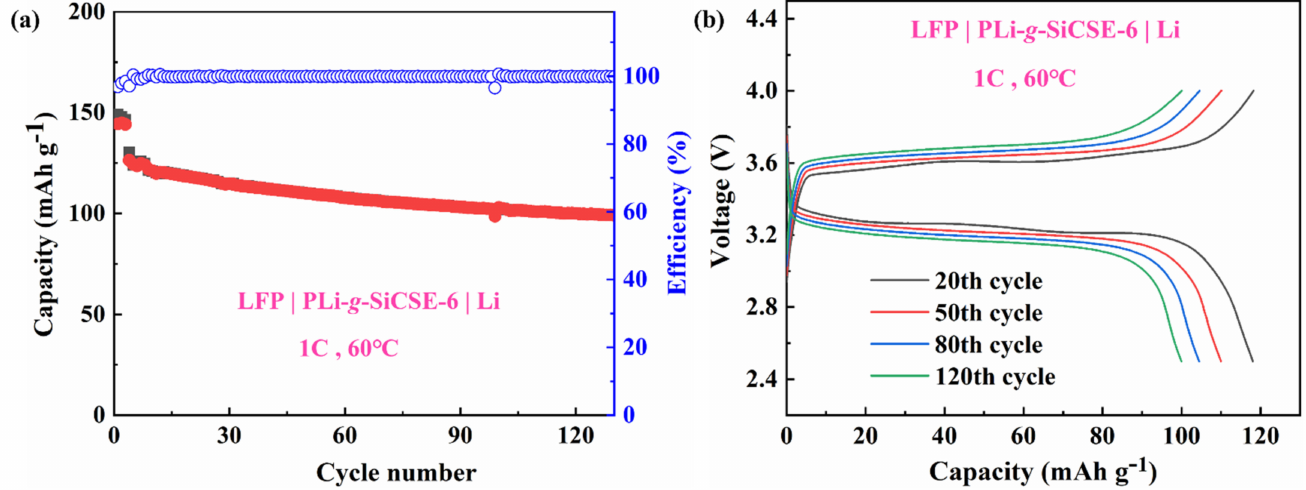
Figure 13. ( a ) Long-term cyclic performance and ( b ) charge and discharge profiles of LFP|PLi- g - SiCSE-6|Li batterie at 1 C (60 ◦